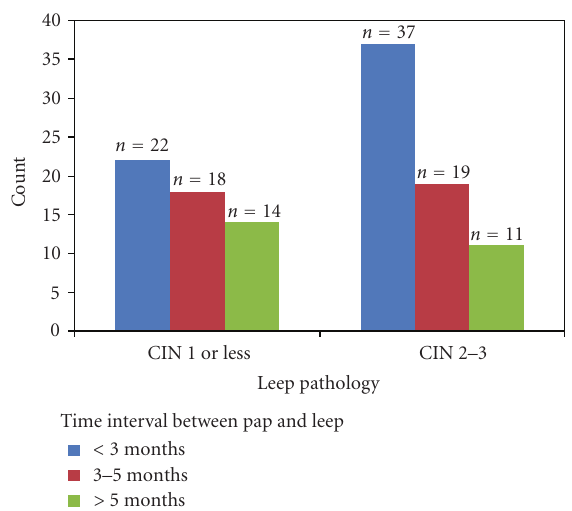
Figure 1: Subjects were divided into two groups by their LEEP histology (CIN 1 or CIN 2,3), and we examined the time interval from their HGSIL Pap to their LEEP. The blue bars signify those subjects who had their LEEP done less than 3 months from the HGSIL Pap. The red bars are those who had their LEEP 3–5 months from the HGSIL Pap. The green bars are those who had their LEEP after 5 months of the HGSIL Pap.